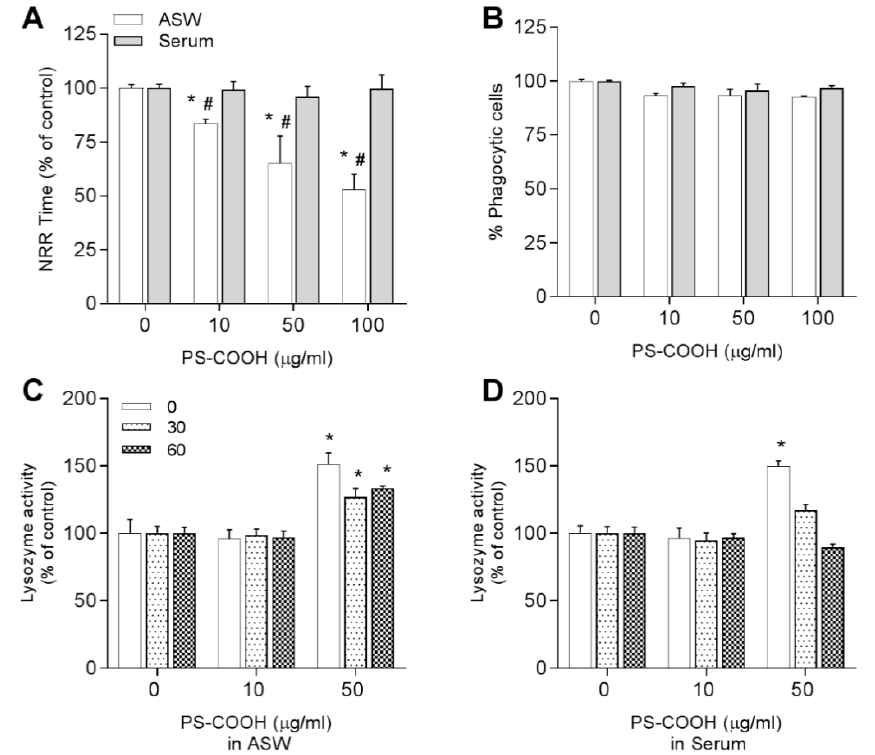
Figure 8. Effects of PS-COOH in different suspension media in ASW (white bars) or hemolymph serum-HS (grey bars) on mussel M. galloprovincialis hemocytes. LMS ( A ), phagocytosis ( B ), and lysozyme activity at time 0, after 30 and 60 min in ASW ( C ) and HS ( D ). Data representing the mean ± SD of four experiments in triplicate, were analyzed by ANOVA followed by Tukey’s post hoc test, ( p < 0.05); * = all treatments vs. controls; # = ASW vs. serum.